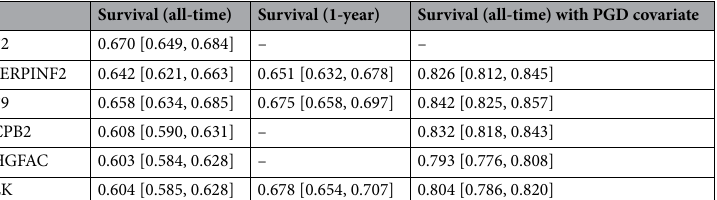
Table 3. Comparison of significantly predictive proteins between survival prediction schemes. Proteins listed were significantly predictive of all-time survival post-transplant after accounting for site-of-origin. Those proteins that did not meet significance criteria are indicated by ‘–’. Predictive significance criteria were: AUROC > 0.5, beta coefficient 95% confidence interval not containing the null association, and permutation beta coefficient interval containing the null association.